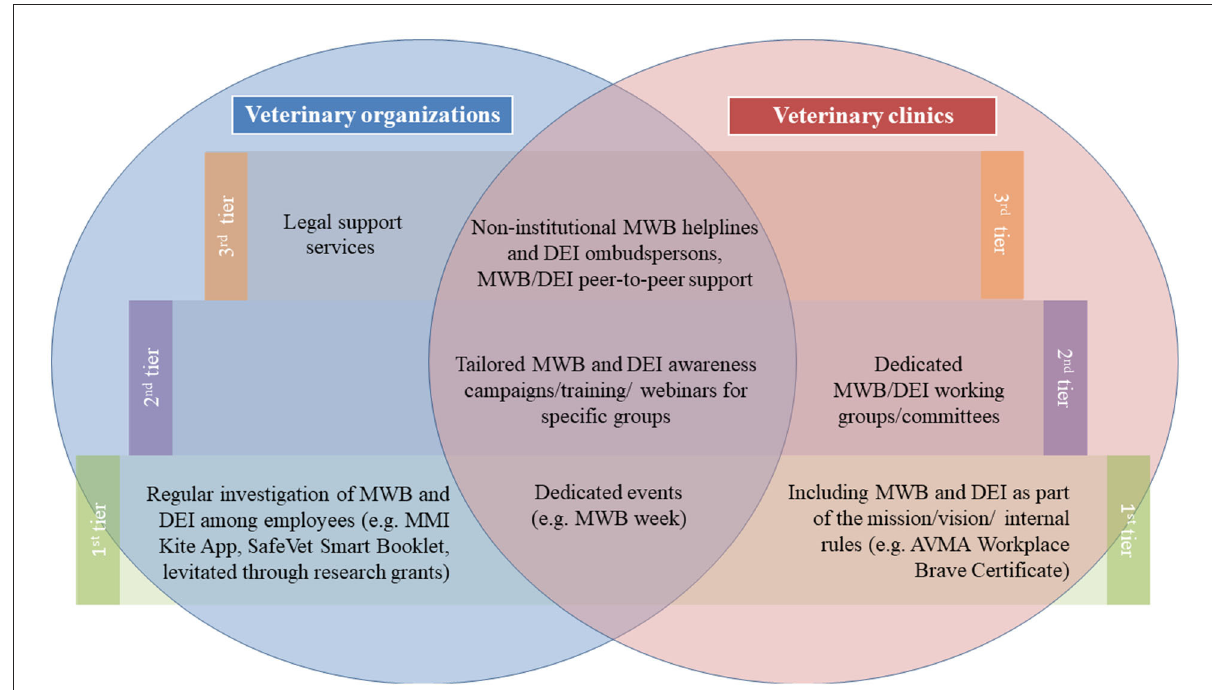
FIGURE7 Venn diagram of MWB and DEI support programs that were identified to be most importantly implemented per tier and per group based on the survey, interview, and webinar